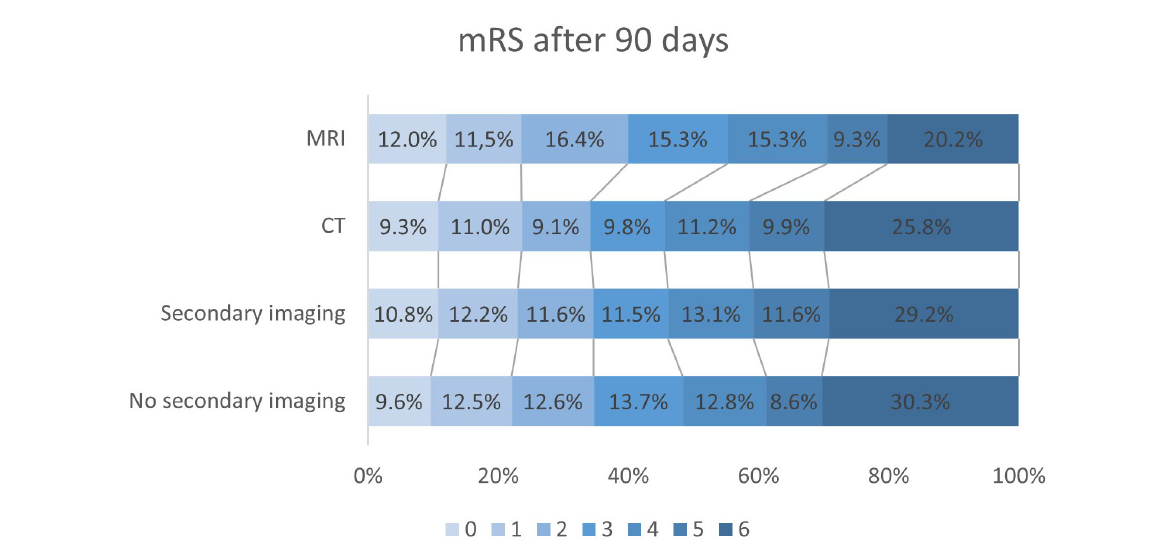
FIGURE4 Modified Ranking scale (mRS) outcome data after 90 days in all drip-and-ship (DS) patients without secondary imaging ( n = 1,171), with secondary imaging in interventional center ( n = 1,045), only CT-imaging ( n = 944) and MRI ( n = 183). Secondary imaging in general did not significantly affect mRS compared to only initial imaging in peripheral centers ( p = 0.206). After multivariable adjustment DS patients undergoing MRI before EVT had lower mRS scores than those without (OR 0.63; 95%-CI 0.46–0.88; p =